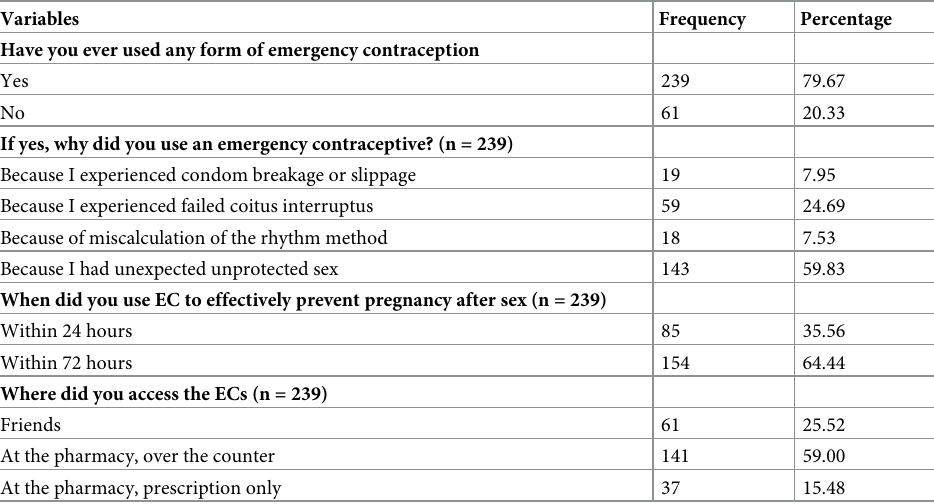
Table 4. Use of emergency contraceptives among women of reproductive age in the Kwadaso Municipality.